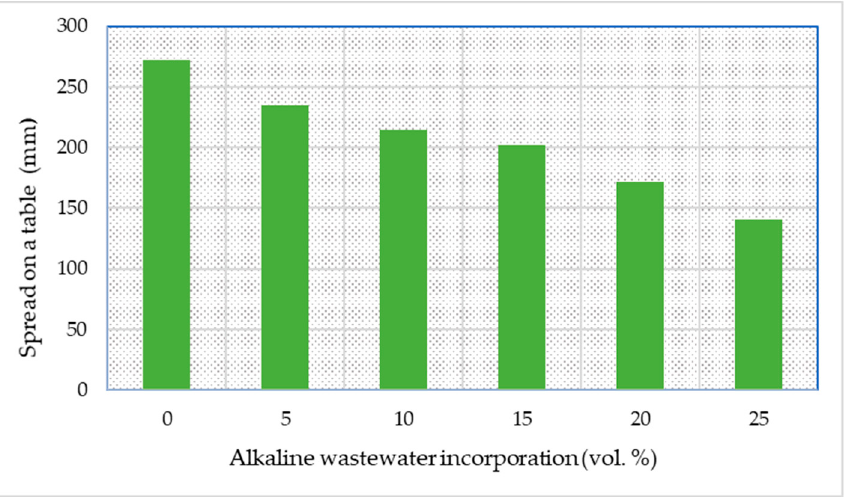
Figure 2. Influence of the alkaline wastewater content on the workability of the pastes (consistency determined by the flow on a table method).